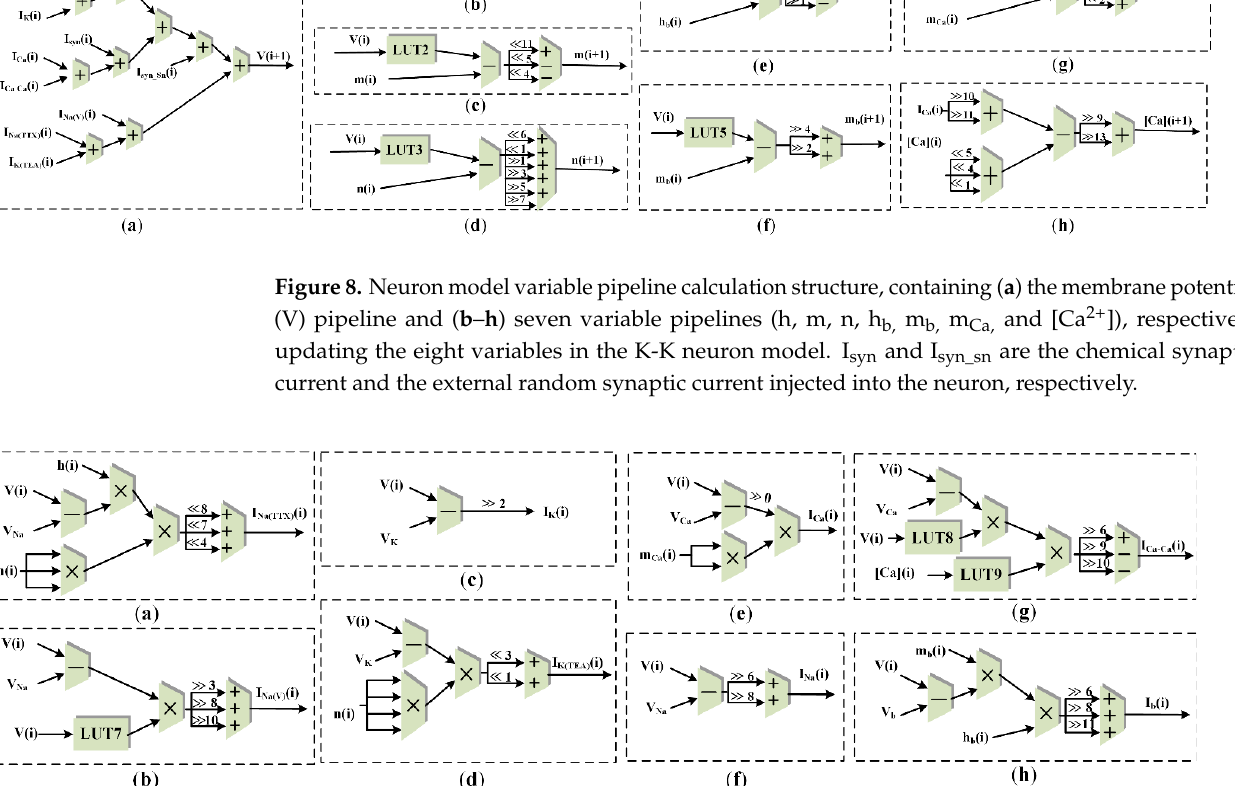
Figure 9. Ionic current variable pipeline calculation structure. Each channel calculates one ionic current in the K-K neuron model separately: ( a ) TTX-sensitive sodium current (I Na(TTX) ), ( b ) the stationary voltage-dependent sodium current (I Na(V) ), ( c ) the leaky sodium current ( I K ), ( d ) the TEA-sensitive potassium current (I E(TEA) ), ( e ) the leaky potassium current (I Ca ), ( f ) the inward calcium current (I Na ), ( g ) the stationary voltage-dependent calcium current (I Ca-Ca ), and ( h ) the voltage-dependent outward current (I b